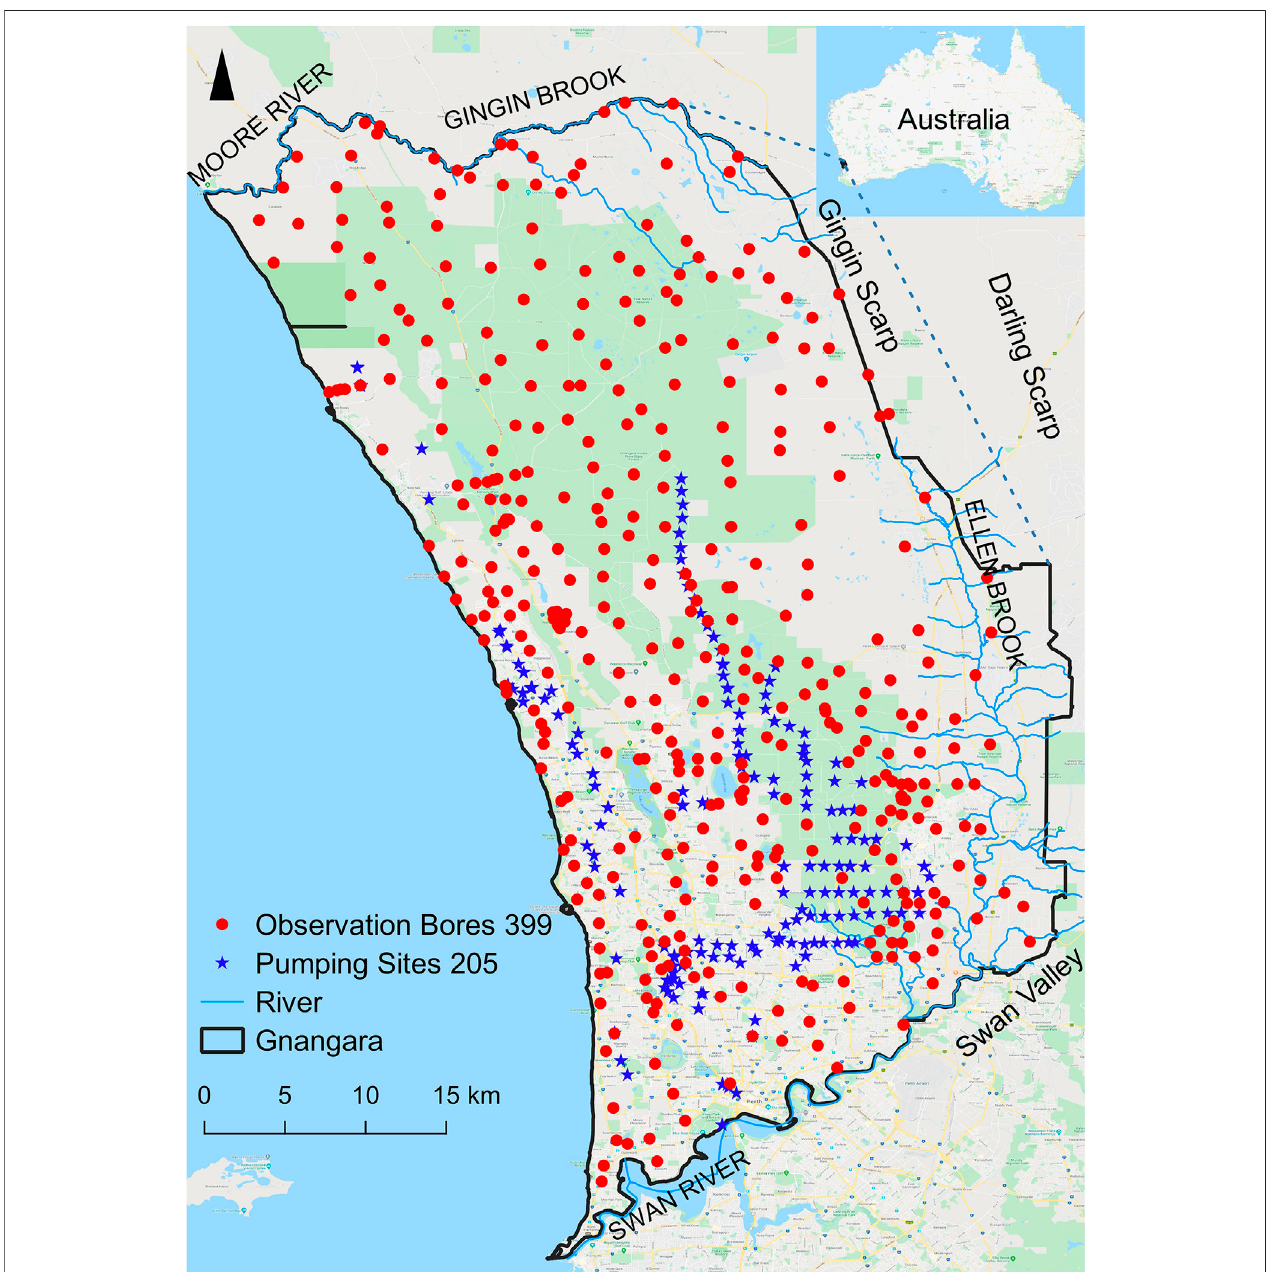
FIGURE 1 | Location of the observation and pumping sites in the Gnangara region, Western Australia.